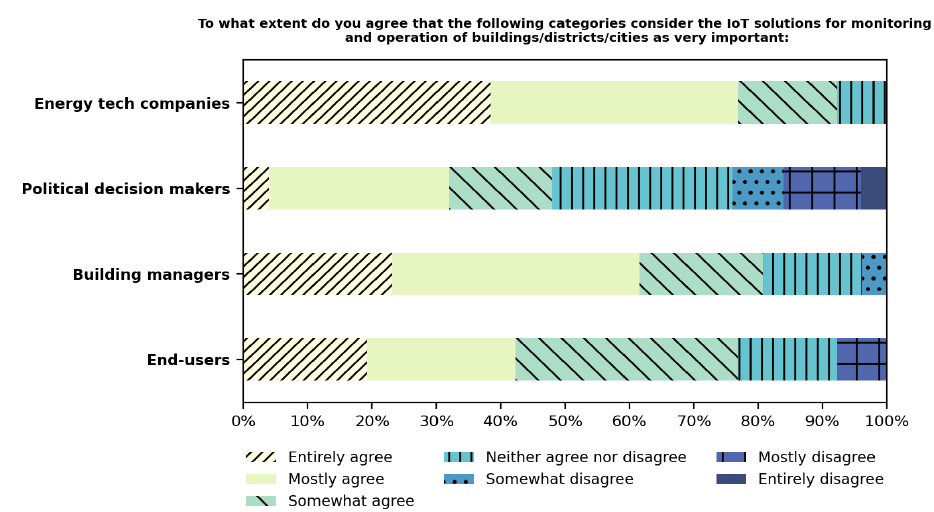
Figure 3. Responses to general survey questions to business owners and end users.